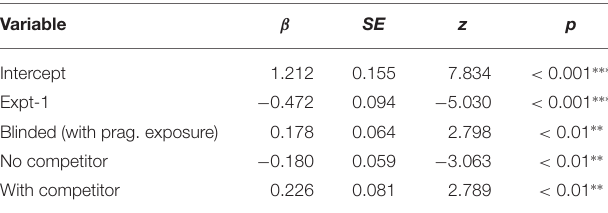
TABLE 9 | Regression coefficients of the logistic linear mixed effects model including the responses from Experiment 1 as well as both halves of Experiment 2. Variable β